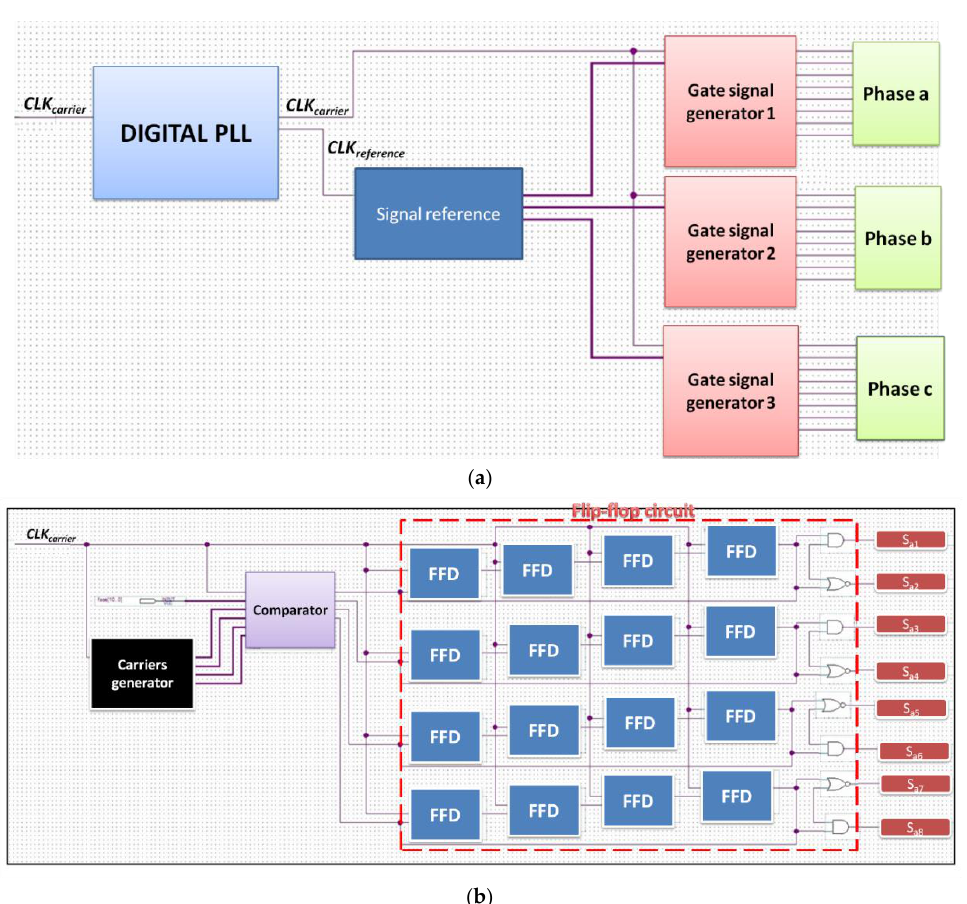
Figure 7. Block scheme of the control software: ( a ) Main schematic, ( b ) Gate signal generator for one phase. PLL: Phase Locked Loop; FFD: Flip-Flop Device.